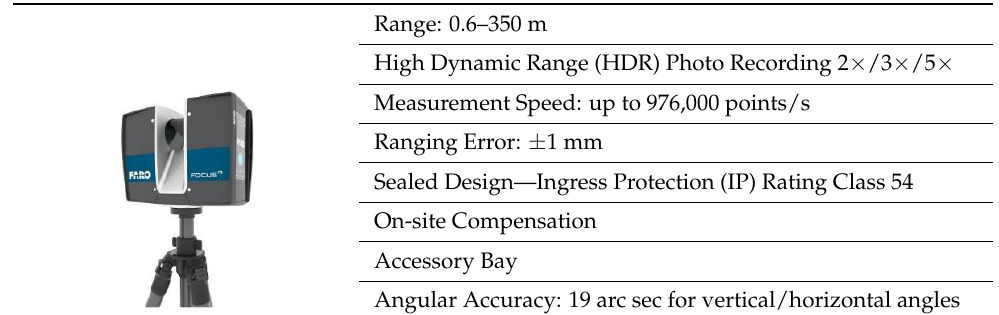
Table 1. Technical information of FARO Focus S350. (https://echosurveying.com/3d-laser-scanner/ faro-focus-s350-laser-scanner, accessed on 2 December 2021).